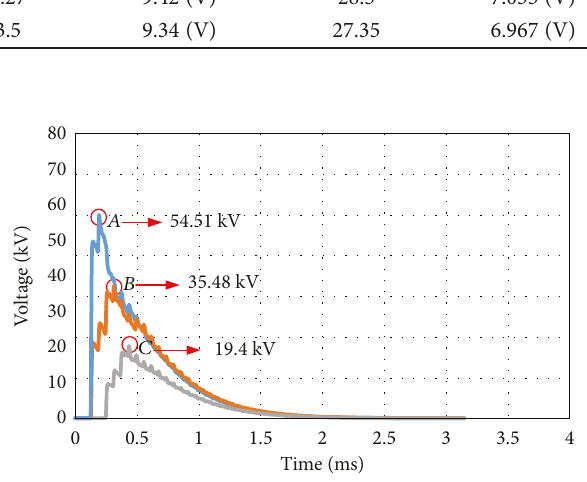
Figure 15: Ground potential rise at point A, B and C after lightning genetic algorithm optimization in the irregular ground